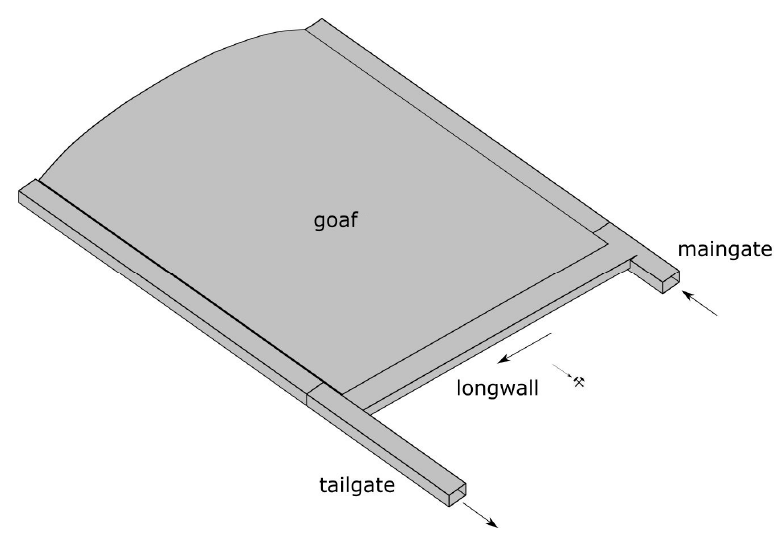
Figure 2. Geometry of numerical model.